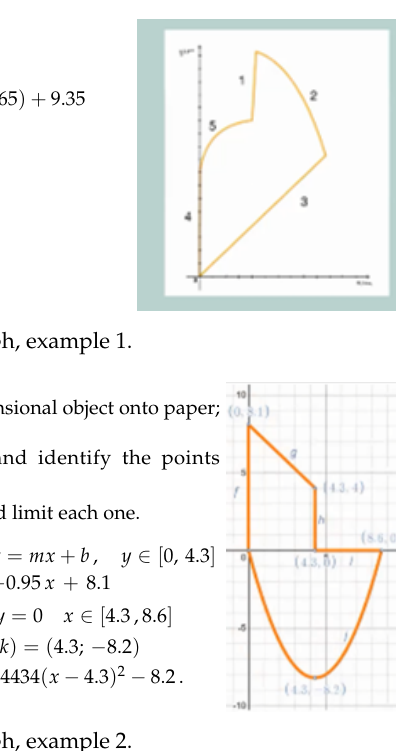
Figure 5. Q2—Desmos use—function and graph, example